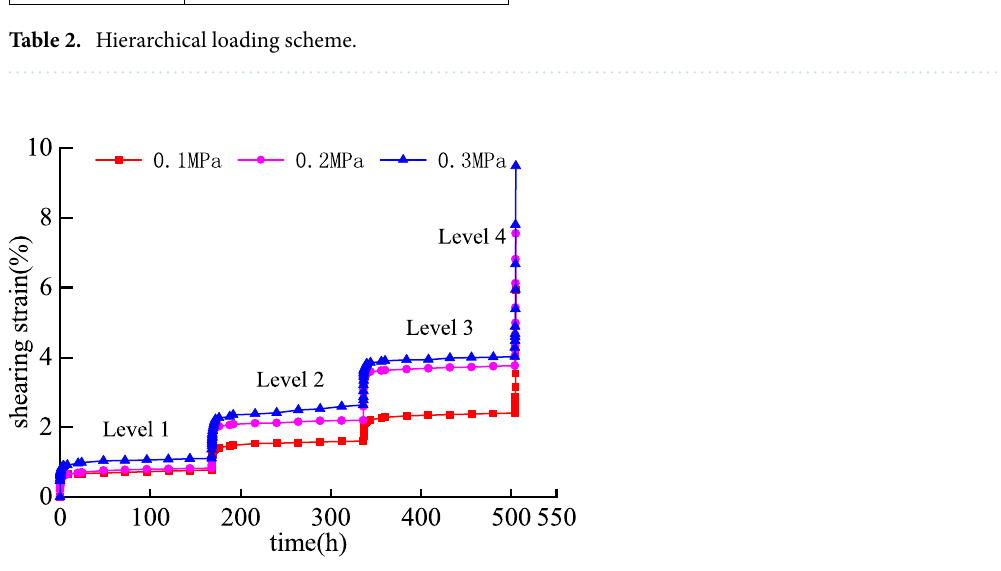
Figure 4. Mudstone creep curve under step